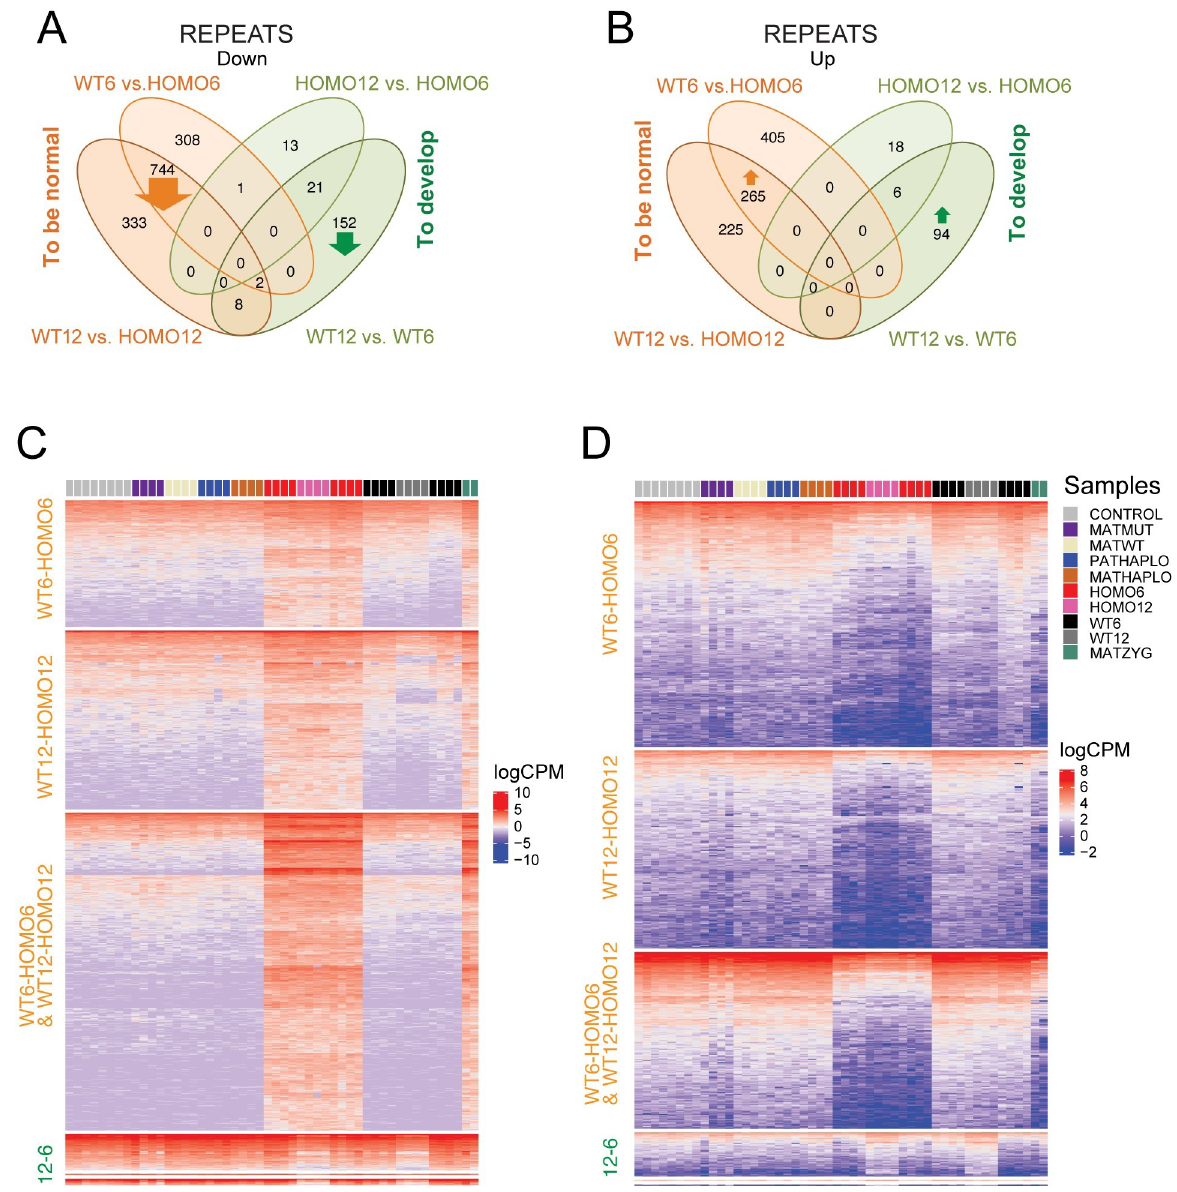
Fig 8. Four-way comparison of uniquely mapped transposable elements. ( A-B ) Venn diagram showing downregulated ( A ) and upregulated ( B ) repeats which were identified using uniquely mapped reads and were stratified according to the four-way comparison. ( C-D ) Heatmaps of downregulated ( C ) and upregulated ( D ) repeats as shown in the above Venn diagrams, with comparisons labeled to the left, samples indicated at the top and color codes shown to the right. The category labeled 12–6 contains WT12-WT6 and HOMO12-HOMO6 and their intersection. Note that most DE repeats are related to genotype. Note the variability of derepression in HOMO6 and MATMUT samples. Note that MATZYG embryos are most similar to HOMO6 embryos.